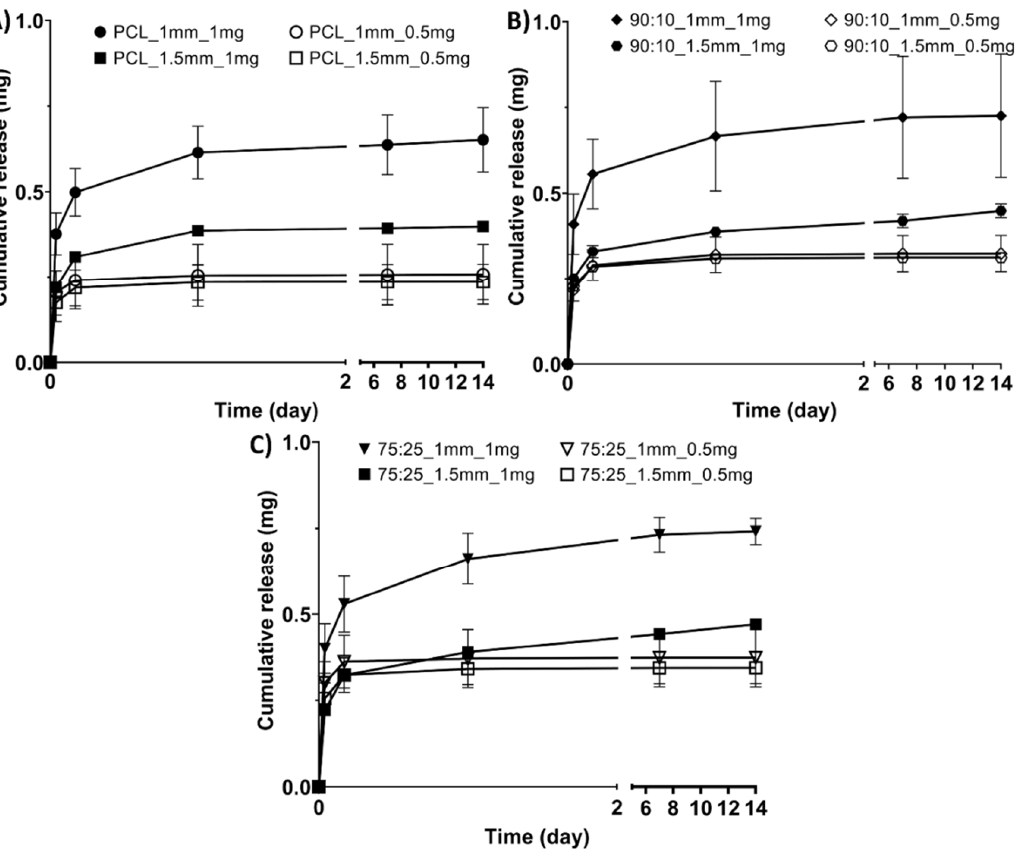
Figure 4. Cumulative antibiotic release profiles for the sample groups: ( A ) PCL groups, ( B ) 90:10 groups, ( C ) 75:25 groups.